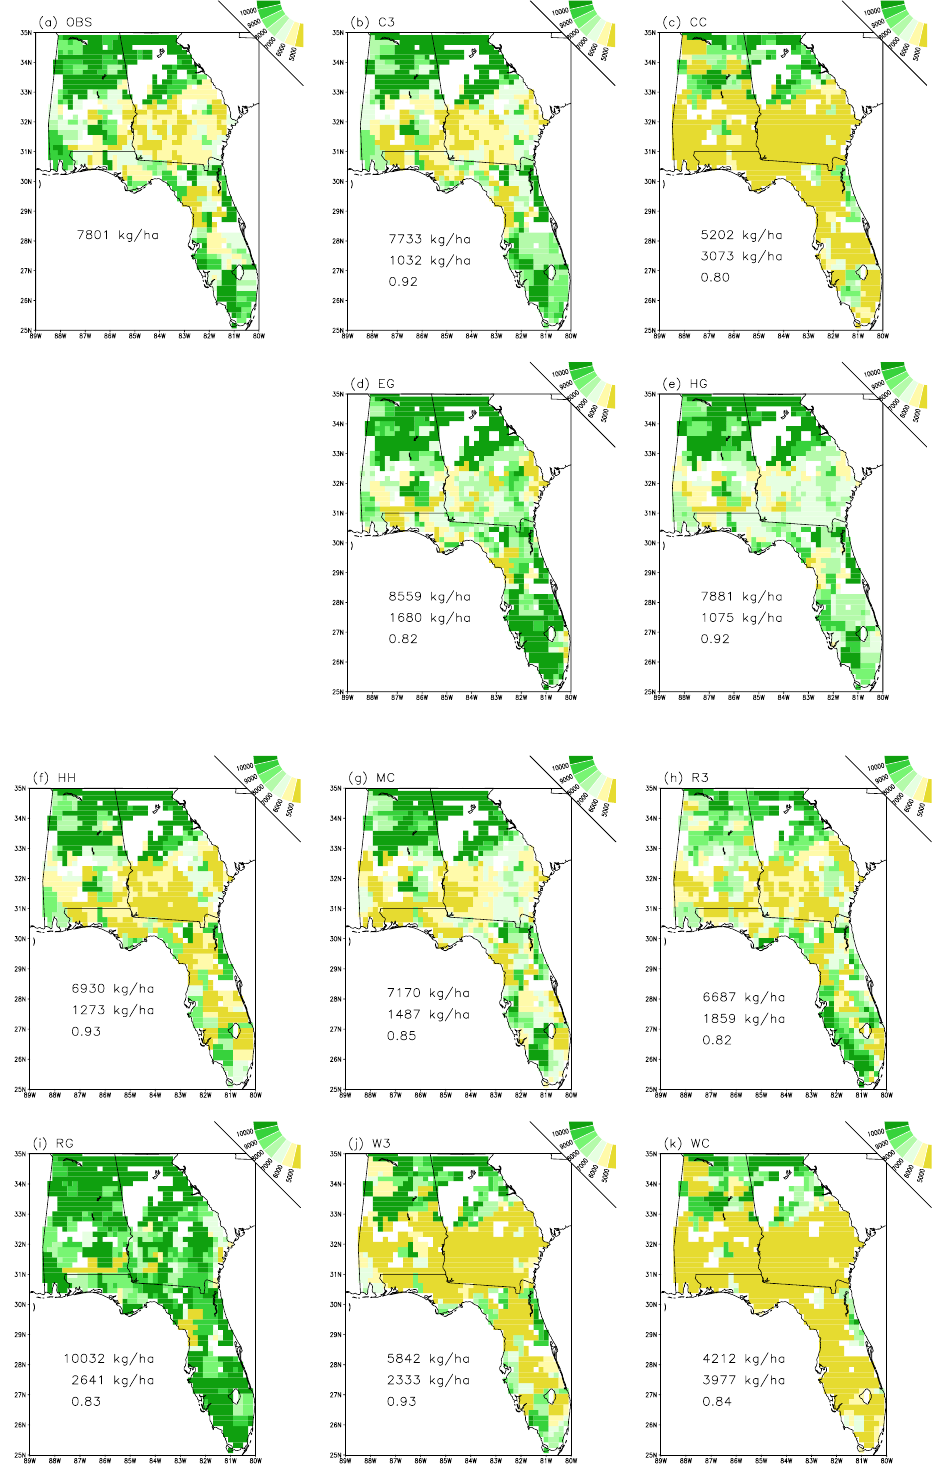
Figure 1. Simulated ( a ) observed-weather-driven and ( b – k ) ten NARCCAP regional-model-driven maize dry matter yields (30-yr average, 1971–2000) under rainfed conditions. Unit is of kg ha − 1 . In each panel, the first value is area averaged yield amount, the second one RMSE, and the third one spatial correlation with the observed-weather-driven yield.